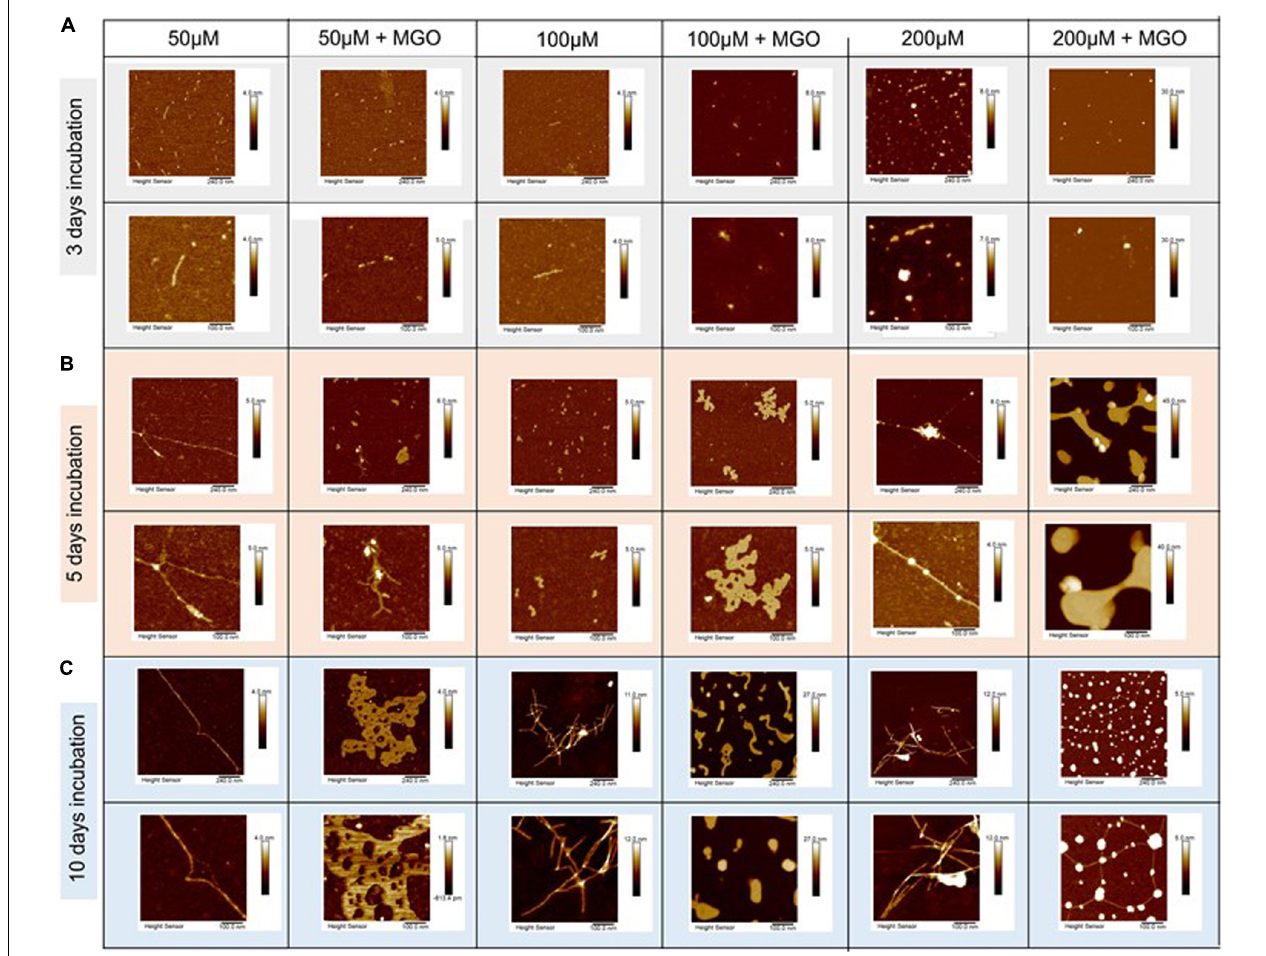
FIGURE 6 | Effects of glycation of IAPP on the aggregate morphology studied by atomic force microscopy. AFM micrographs of IAPP at concentrations of 200, 100, and 50 µ M incubated with 20-fold ratio MGO in PBS at 3 day (A) , 5 day (B), and 10 day (C) incubation. IAPP images are displayed from a 5 µ m scale (top row) to 500 nm scale (bottom row). The images show that glycation